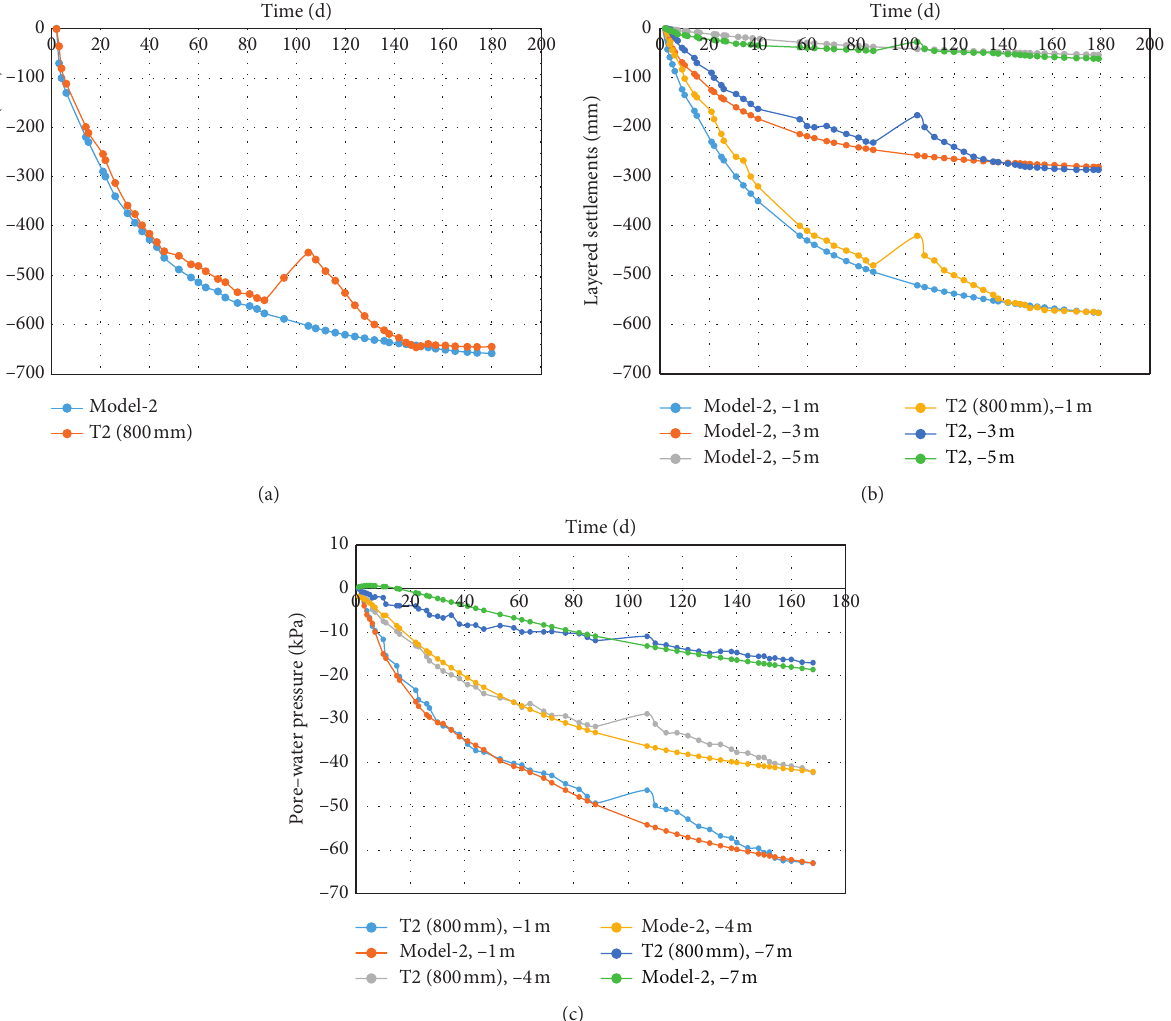
Figure 13: Comparison of numerical solution and measured data: (a) surface settlement; (b) layered settlements; (c) pore water pressures.